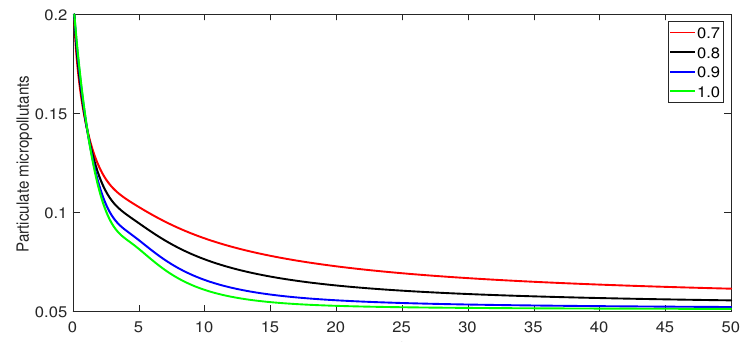
Figure 4. Graphical illustration of the model (8) for SMX and various values of δ